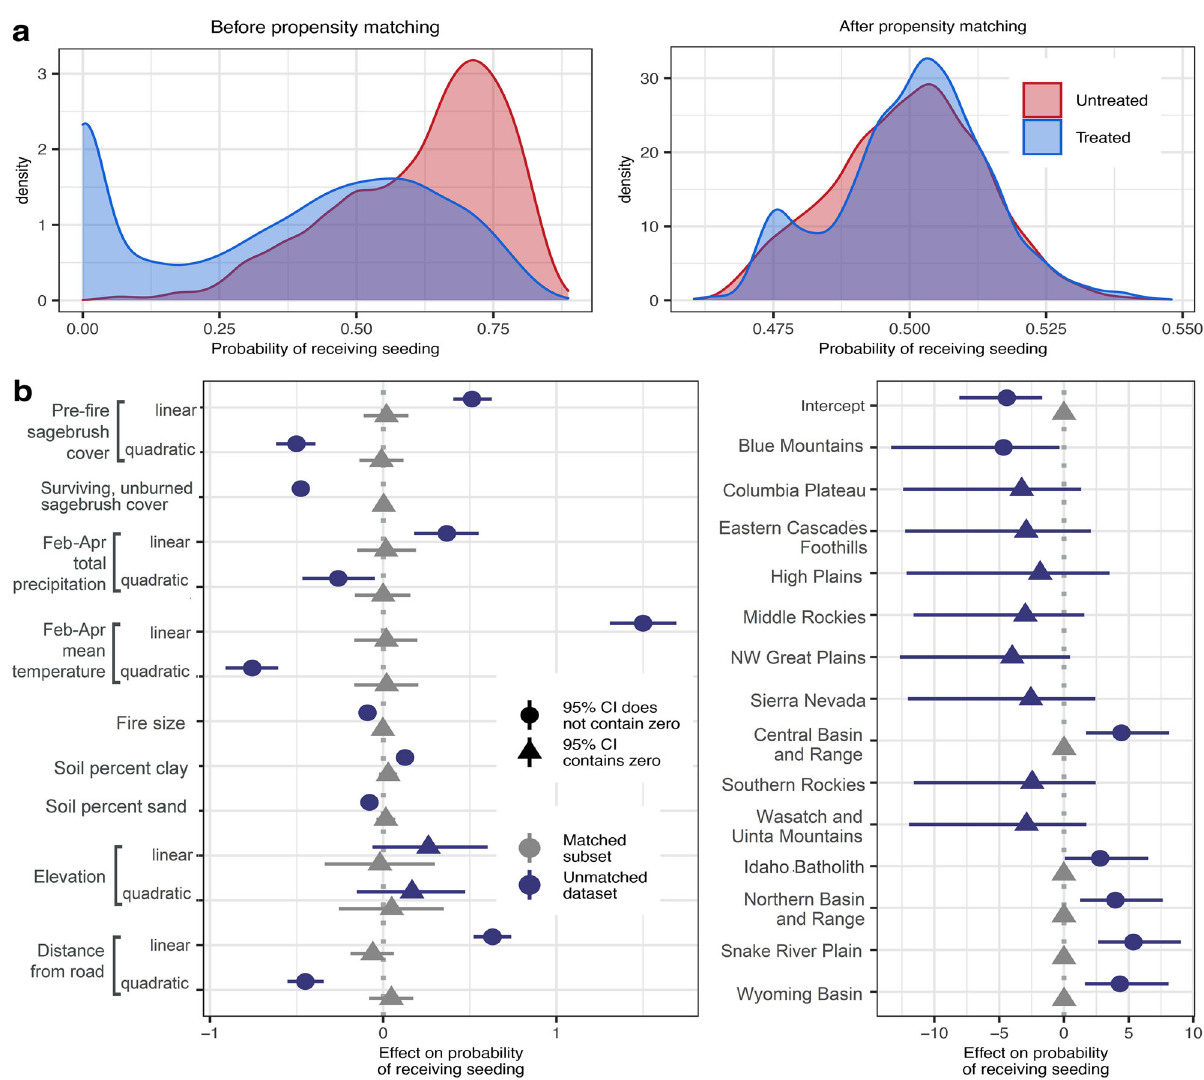
Fig. 2 Differences in treated and untreated site characteristics before and after propensity score matching. a The distribution of propensity scores (the probability of receiving seeding treatment) in treated and untreated locations before ( n = 20,000 locations) and after the matching process ( n = 11,012 locations); ( b ) Posterior parameter estimates for the effects of environmental covariates in unmatched and matched datasets on the probability of receiving seeding treatments ( n = 20,000 locations). Symbols represent median parameter estimates and lines represent the 95% credible intervals (CIs) for the parameter estimate, with triangles and dots indicating where 95% CIs included 0 or did not include 0, respectively. In the matched dataset, the effects for some ecoregions are not shown, in cases where the matching algorithm eliminated observations from these ecoregions entirely (i.e. no suf fi ciently similar pairs of treated and untreated pixels were contained within these ecoregion